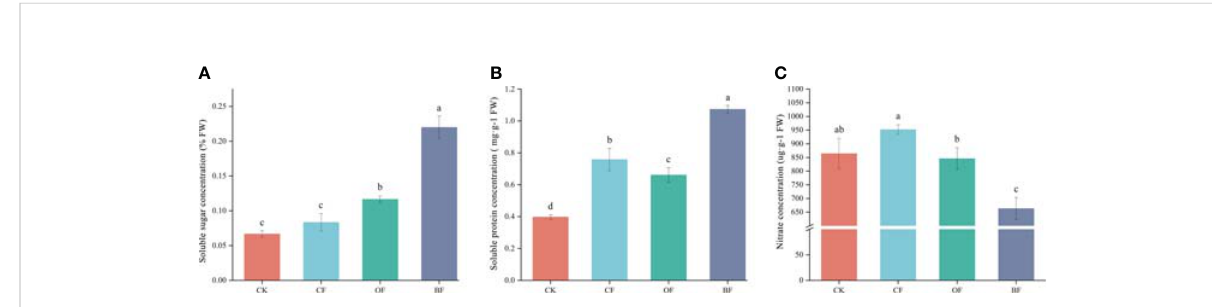
FIGURE 1 Effects of different fertilizer treatments on the Brassica chinensis L. soluble sugar concentration (A) , soluble protein concentration (B) and nitrate concentration (C) . CK is the untreated control; CF is chemical fertilizer; OF is organic fertilizer; BF is bioorganic fertilizer; FW is fresh weight. Means (N = 3) within the same histogram followed by the same letter are not statistically different ( P = 0.05) according to Duncan ’ s new Multiple-Range test. The different small lettles (a, b, c, and d) indicated the signi fi cant difference among the different groups at P<0.05